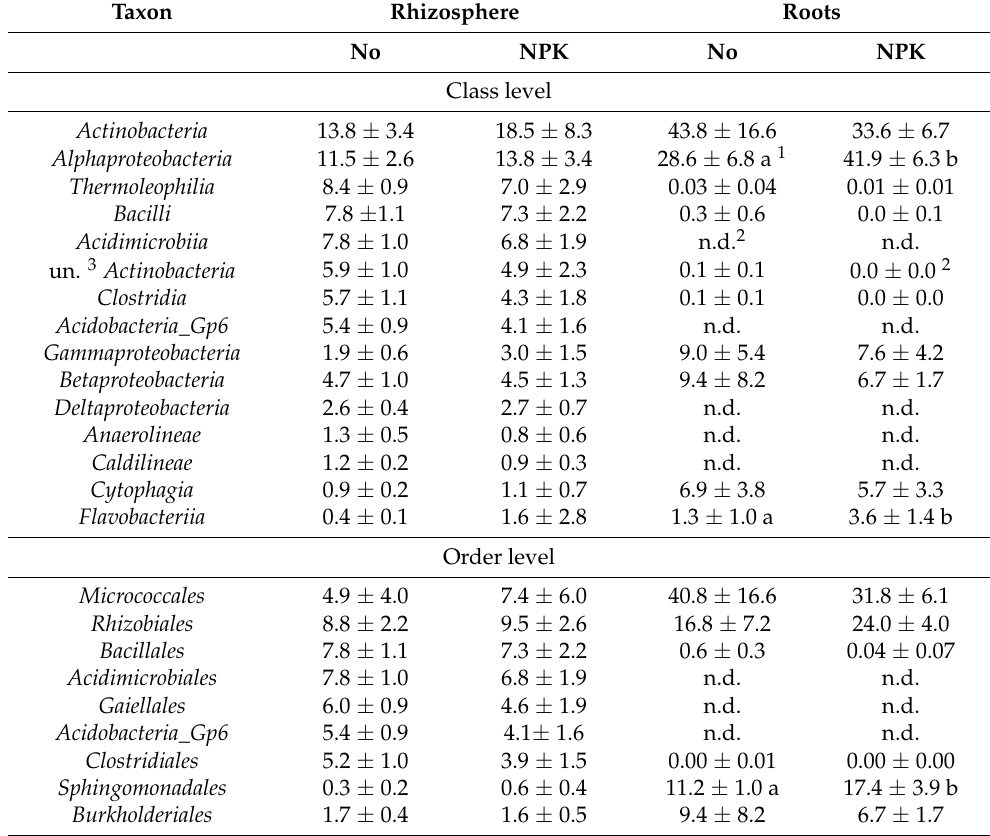
Table 1. The relative abundance (%, mean ± standard deviation) of the dominant bacterial taxa in the rhizosphere and roots of tomato plants, grown under different fertilization on Phaeozem in the open field in the south of West Siberia (a taxon was considered dominant if its relative abundance was ≥